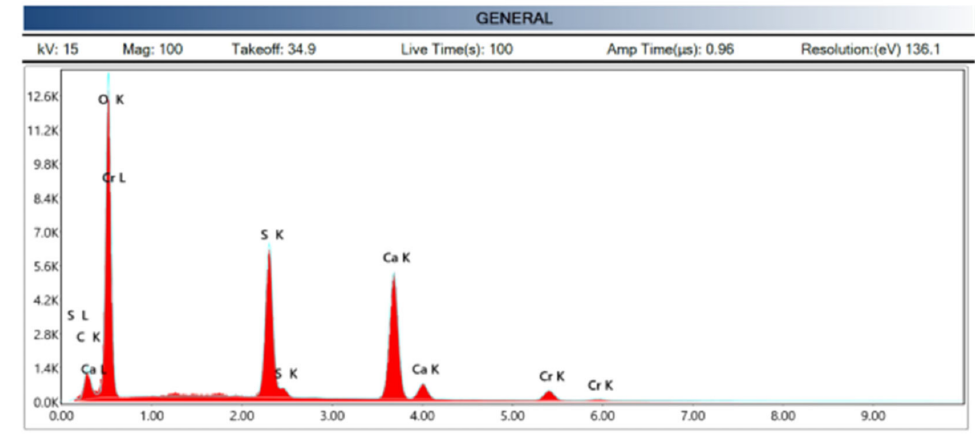
Figure 19. X-ray spectrograph of sample Y1 of calcium sulfate without additives. (source: the